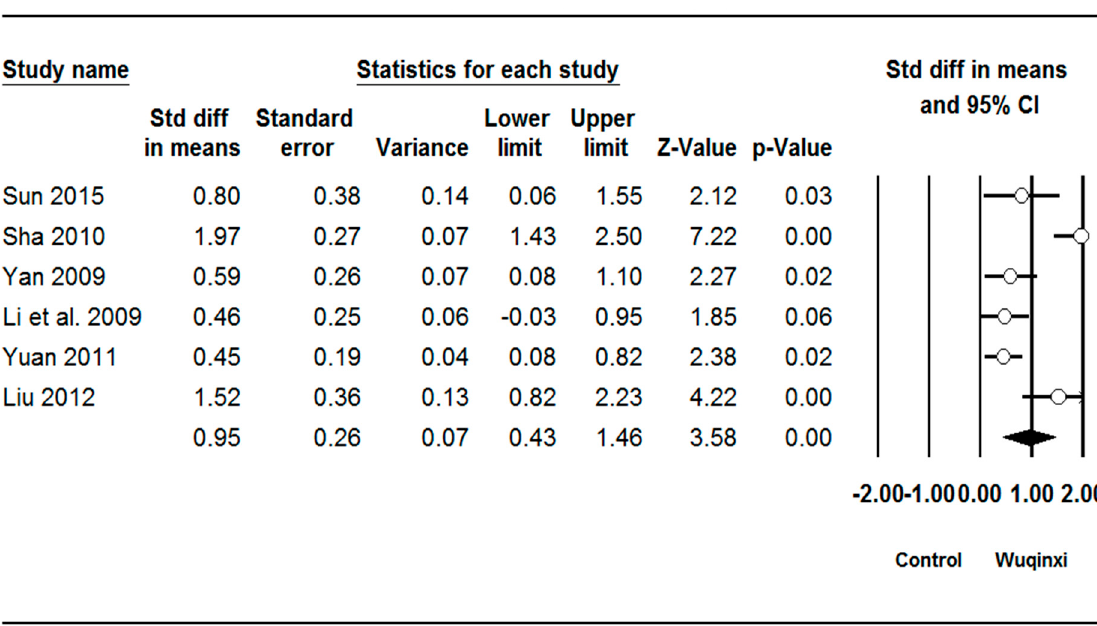
Figure 7. Effect of Wuqinxi on high-density lipoprotein cholesterol. Effect size (95% CI) of each study is denoted by circle (black line). The mid-point of the circle represents the point effect estimate, meaning effect estimate for each study. The area of the circle represents the weight given to the study. The diamond below the studies represents the overall effect.